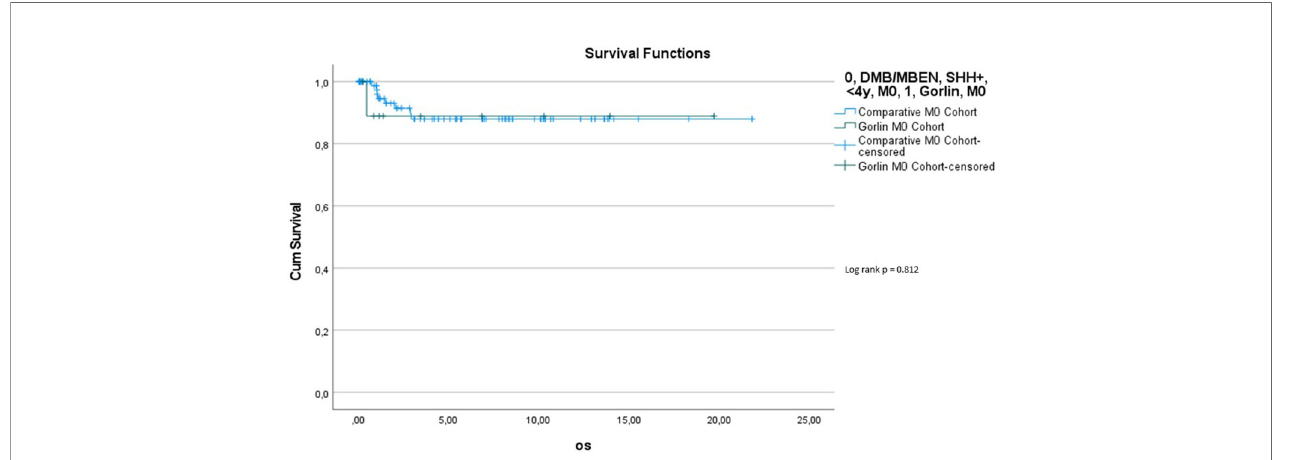
FIGURE 10 | Comparison of OS (Gorlin M0 cohort vs . Comparative M0